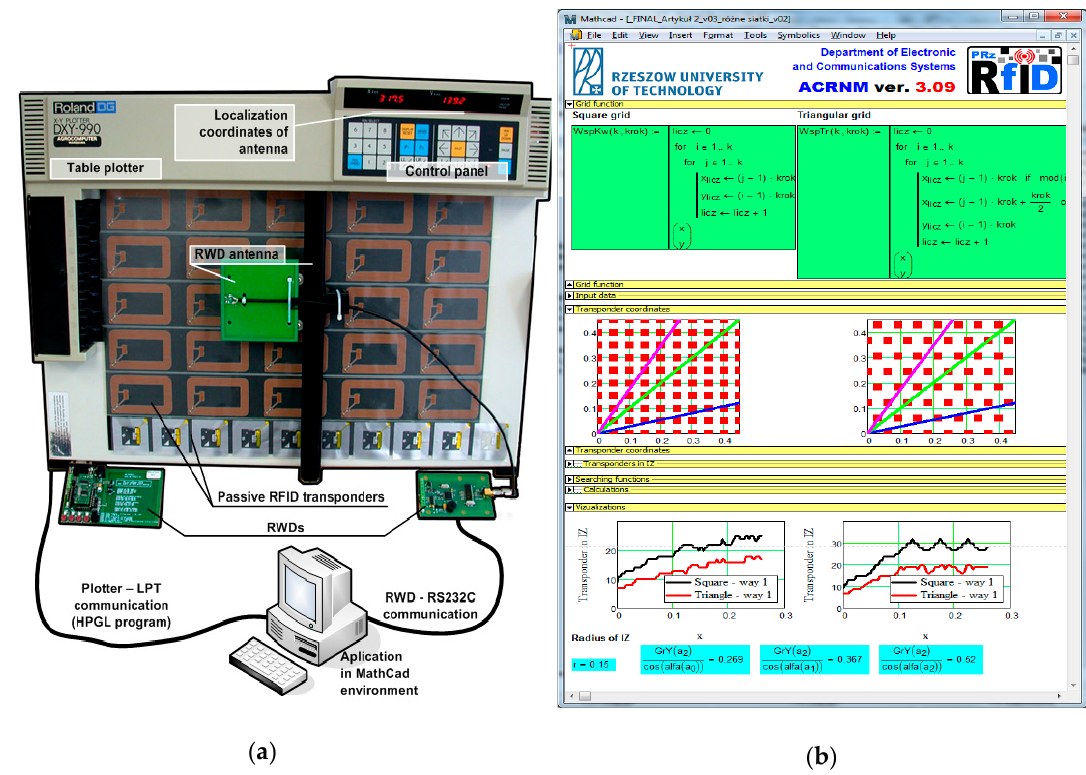
Figure 31. Laboratory stand for testing autonomous navigation system in scope of configuration network of reference points: ( a ) Hardware; ( b ) Software tool in Mathcad environment.